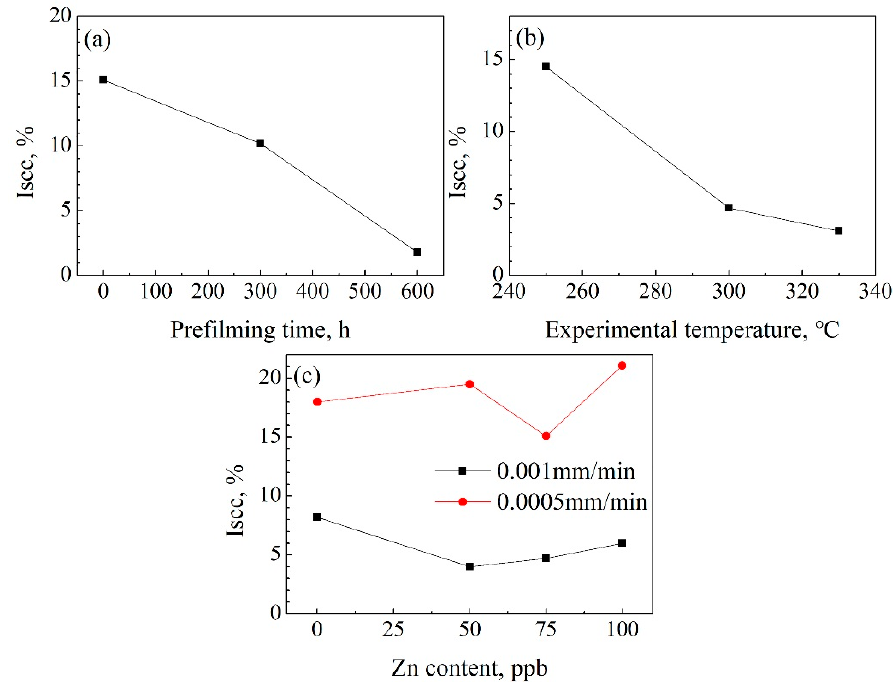
Figure 4. ( a ) I scc vs. prefilming time; ( b ) I scc vs. the experimental temperature; and ( c ) I scc vs. Zn content in the chemical solution.